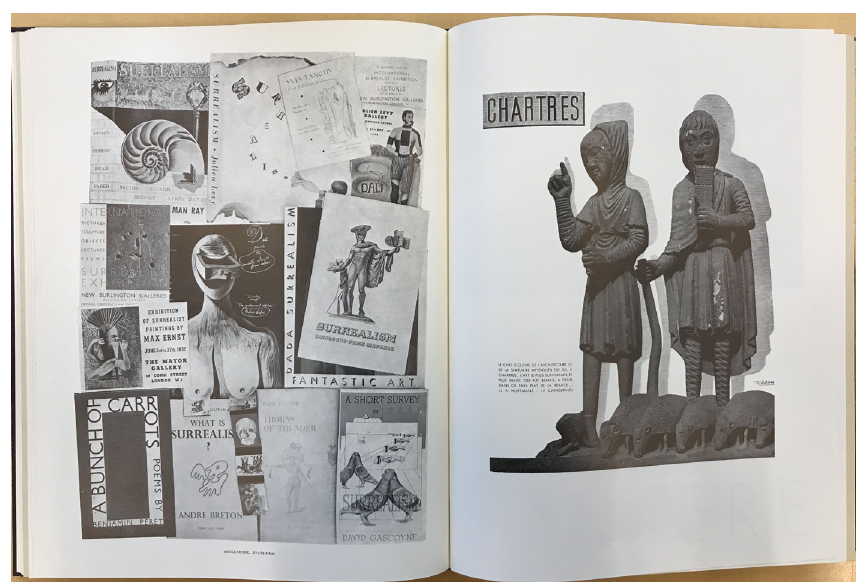
Fig. 10 Page spread from Minotaure , no. 10 (1937), pp. 64–65. Photo: